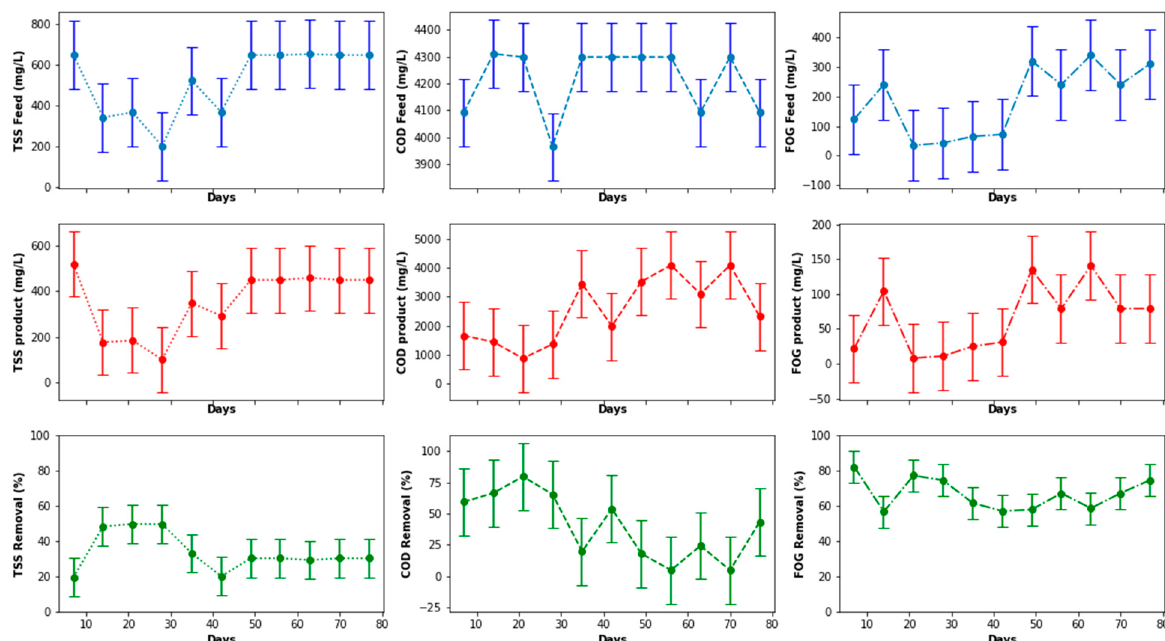
Figure 8 . Pretreatment stage performance assessed using COD, TSS, and FOG concentration removal. Figure 8. Pretreatment stage performance assessed using COD, TSS, and FOG concentration